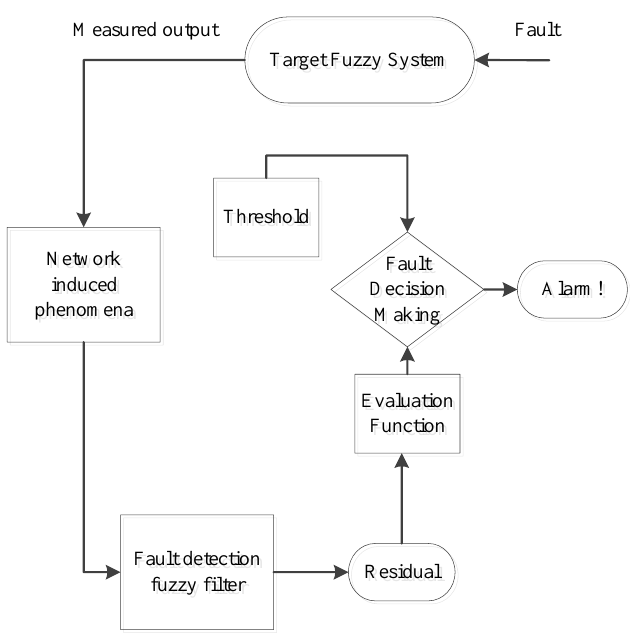
Figure 11. Fuzzy Logic (FL)-based fault detection and isolation